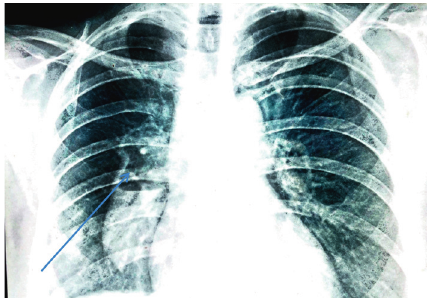
Figure 2: CXR showing lung